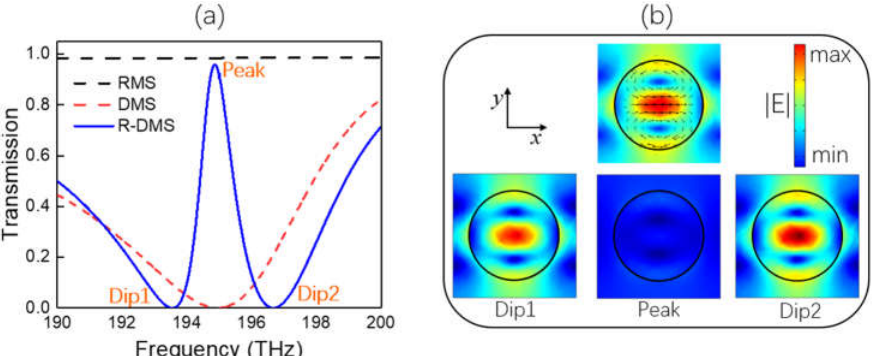
Figure 4. ( a ) Transmission curves for individual 2D DMS (red dashed line), individual 1D RMS (black dashed line), and double-layer R-DMS (blue solid line) when t = 600 nm. Dip1, Dip2 and Peak refer to frequencies of the two dips and peak in the EIT transparency window, respectively. ( b ) The first row displays the electric near-field distribution and displacement current at the resonance of 195 THz for the individual DMS, the second row is the electric near-field distributions in the disk at Dip1, Peak and Dip2 after being